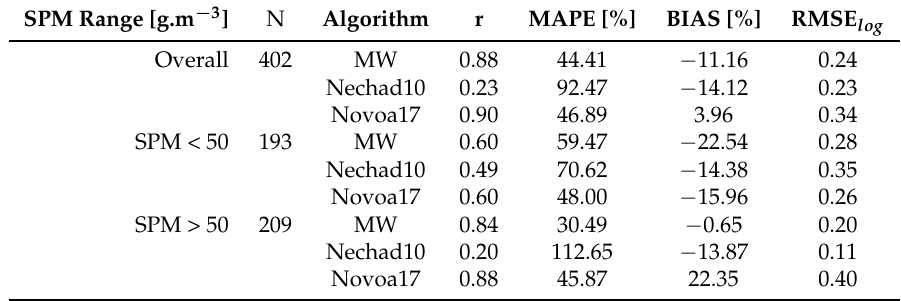
Table 7. Overall performance metrics for the different SPM algorithms of field data at different SPM